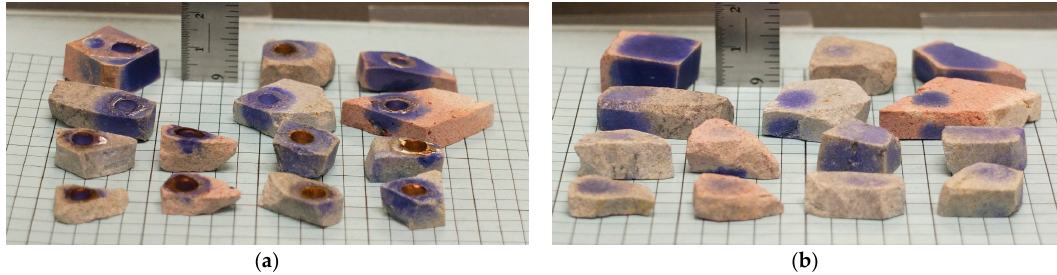
Figure 8. ( a ) Top surface of thick slabs with ink dimples; ( b ) Bottom surface of slabs showing ink breakthrough. Exposure times from six hours to three days. Top row of samples, left to right: pink, gray pink; Second row: gray, gray pink; Third row: gray, pink, gray, gray; Bottom row: gray, pink, gray, gray.